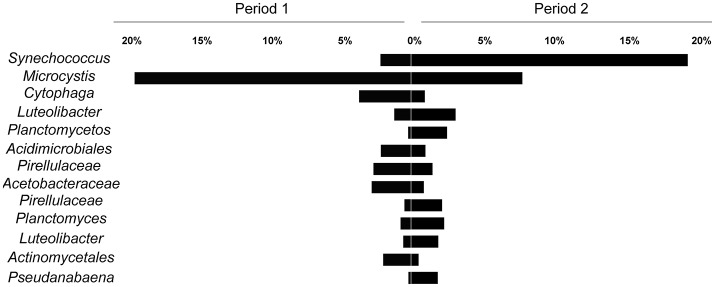
Average relative contribution of OTUs in the two defined periods (Period 1 from October to mid January and Period 2 from mid January to March). The selected OTUs contributed to at least 2% for the differentiation between the periods (SIMPER analysis).